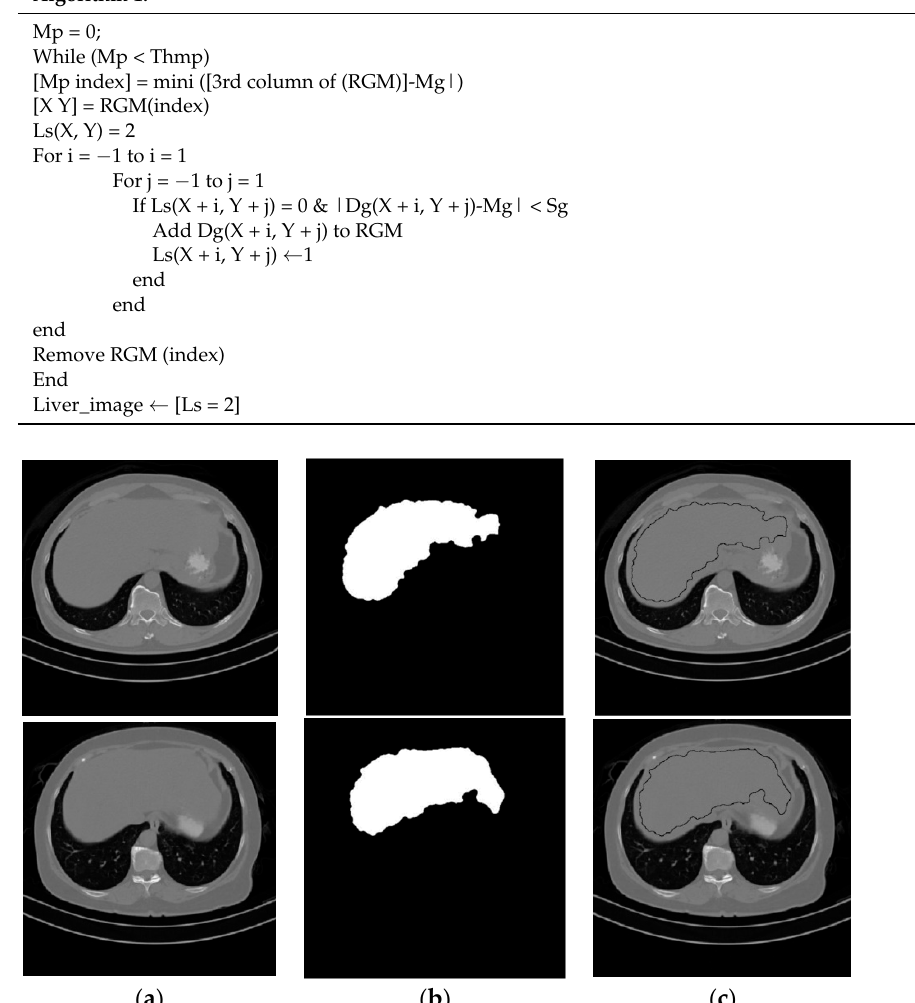
Figure 4. Samples from the liver seed segmentation results. ( a ) Original, ( b ) seed segmented liver, ( c ) boundary of the seed segmented liver.